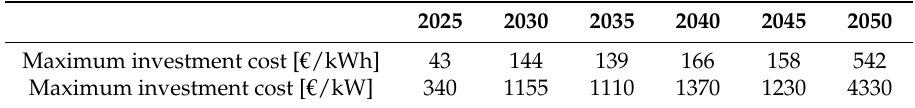
Table 7. Maximal annualized investment costs of storage based on energy and power capacity, respectively.